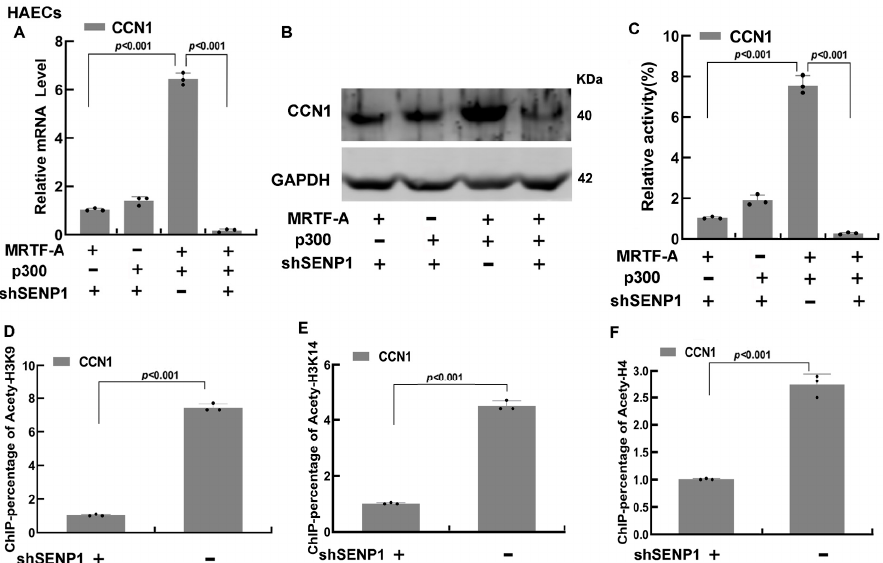
Figure 5. SENP1 knockdown inhibited the acetylation of CCN1 by P300. HAECs were co-transfected with MRTF-A, P300, and shSENP1. ( A , B ) The expression of CCN1 were examined by qRT-PCR and Western blot. ( C ) CCN1 transactivation was analyzed using luciferase assay after 24 h transfection of MRTF-A, P300, shENP1, and CCN1 promoter-Luc plasmids into HAECs. ( D – F ) ChIP assays were performed in HAECs after transfection, and cross-linked chromatin was immunoprecipitated with specific anti-acetyl-h3K9/h3K14 /h4 antibodies and IgG antibody as a negative control. The signs ‘+’ means present and ‘–’ means absent for the conditions indicated in each graph. Quantitation is shown as the means ± SD ( p values are as indicated, n = 3. Individual data points were shown as scattered black dots).